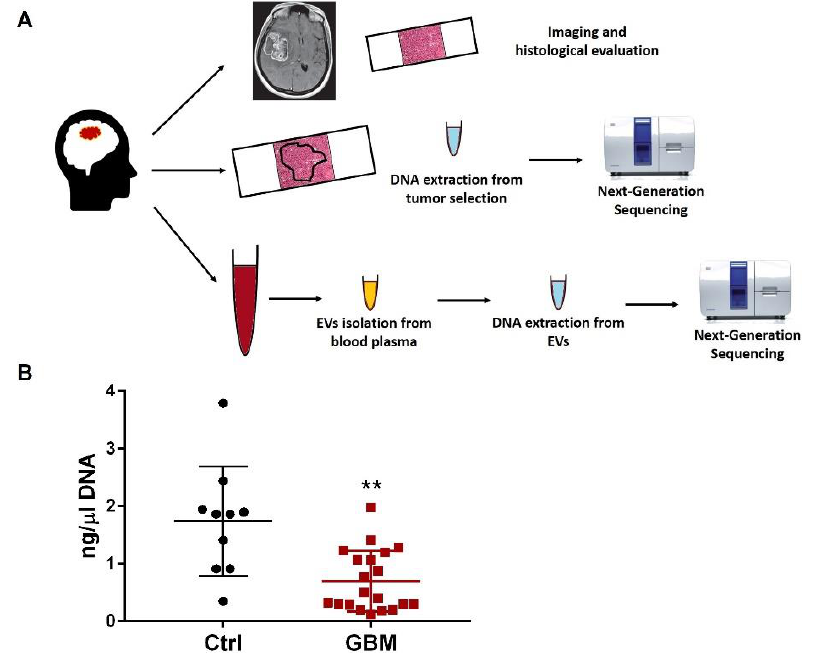
Figure 1. ( A ) Experimental workflow of the study. Brain tumor imaging and histopathological analysis were performed for cancer staging. A peripheral blood sample was also obtained from patients to isolate EVs. Afterwards, DNA was isolated in parallel from both paraffin-embedded sections and matched EVs and genomic mutations assessed by NGS analysis. ( B ) Blood-plasma-derived EV DNA concentration yield in patients with glioblastoma ( n = 20) compared to healthy donors ( n = 10). ** p < 0.01. GBM, patients with glioblastoma, Ctrl, controls.